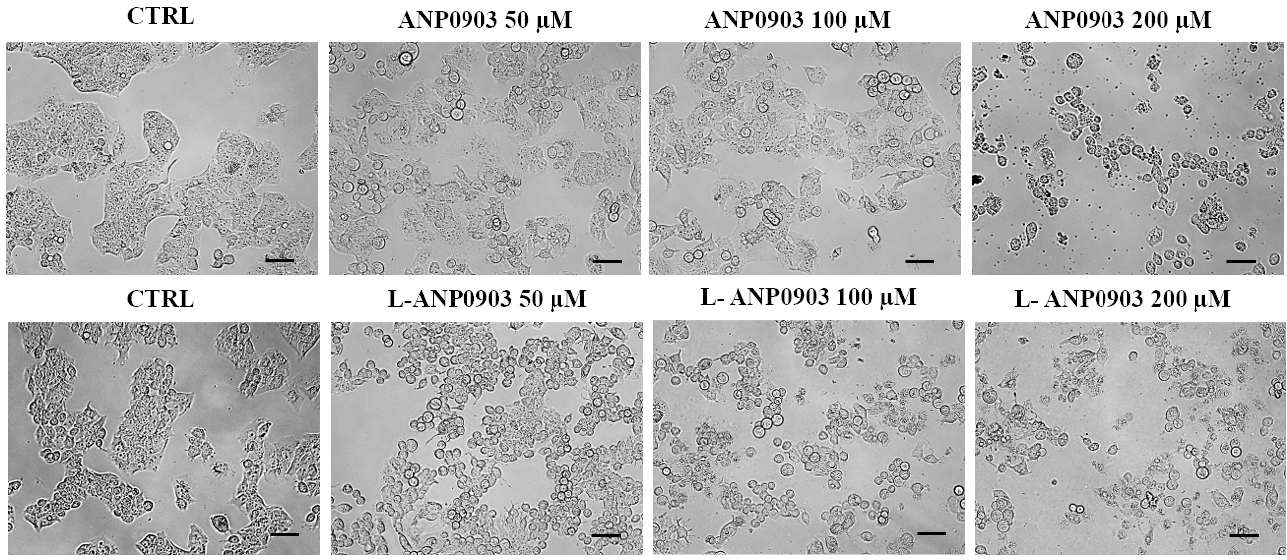
Figure 4. Morphological analysis of cells after exposure to ANP0903 and its liposomal formulation. HepG2 cells were observed under light microscopy with 40× magnification after exposure to the indicated concentrations for 24 h. Scale bars: 100 µm.